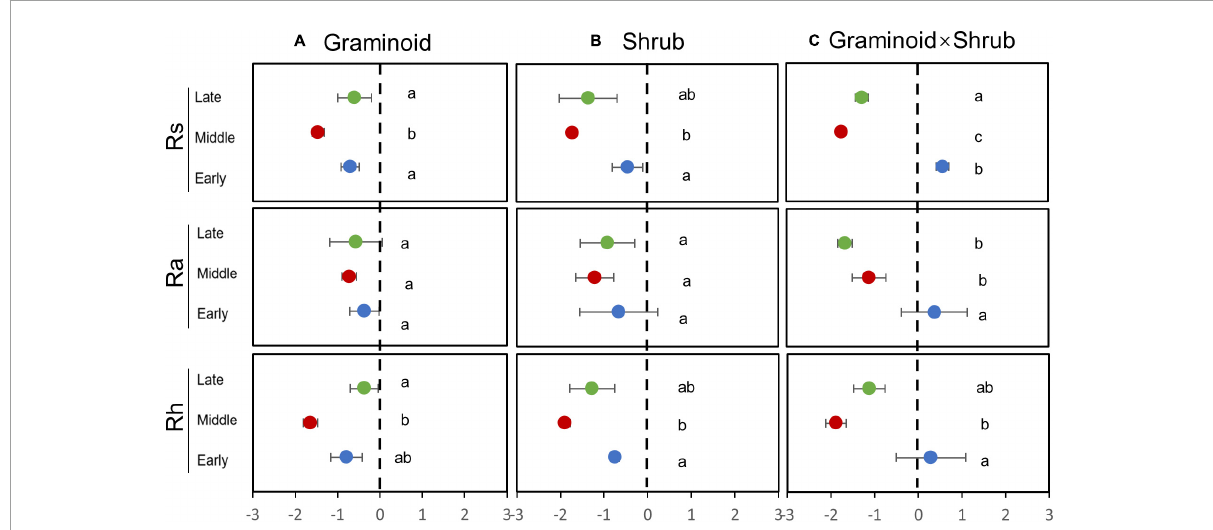
FIGURE3 Sensitivity of Rs, Rh, and Ra responses to drought treatment in the G (A) , S (B) , and GS plots (C) . Sensitivity is a dimensionless parameter [Eq. (1)]. Different letters indicate significant differences ( P ≤ 0.05) between treatments.